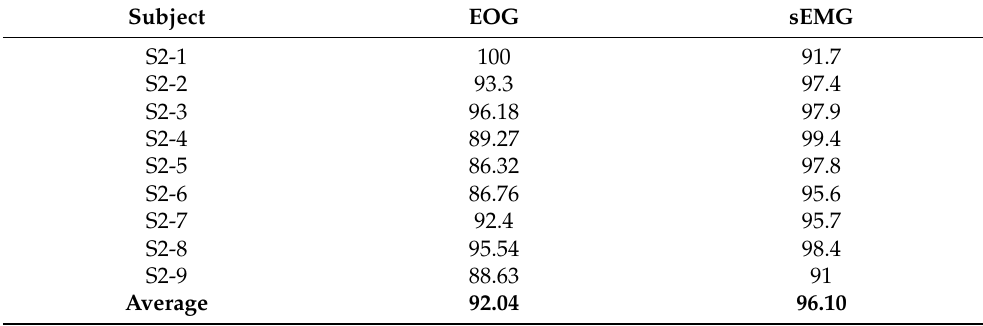
Table 1. EOG and sEMG signal based command accuracy results in virtual keyboard interface